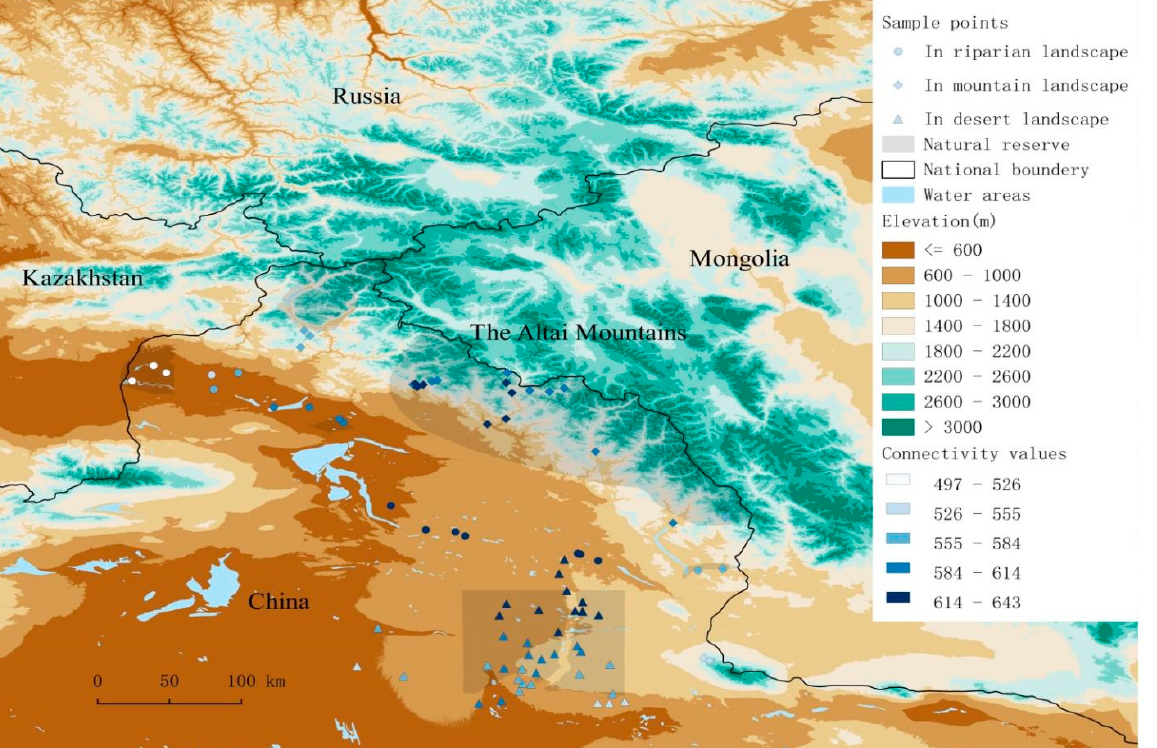
Figure 1. Study area and location of transect lines. Transect lines located in mountain landscape- square points; riparian landscape-circle points; desert landscape-triangular points. Connectivity values are showed as a graduated blue color from low value to high value.